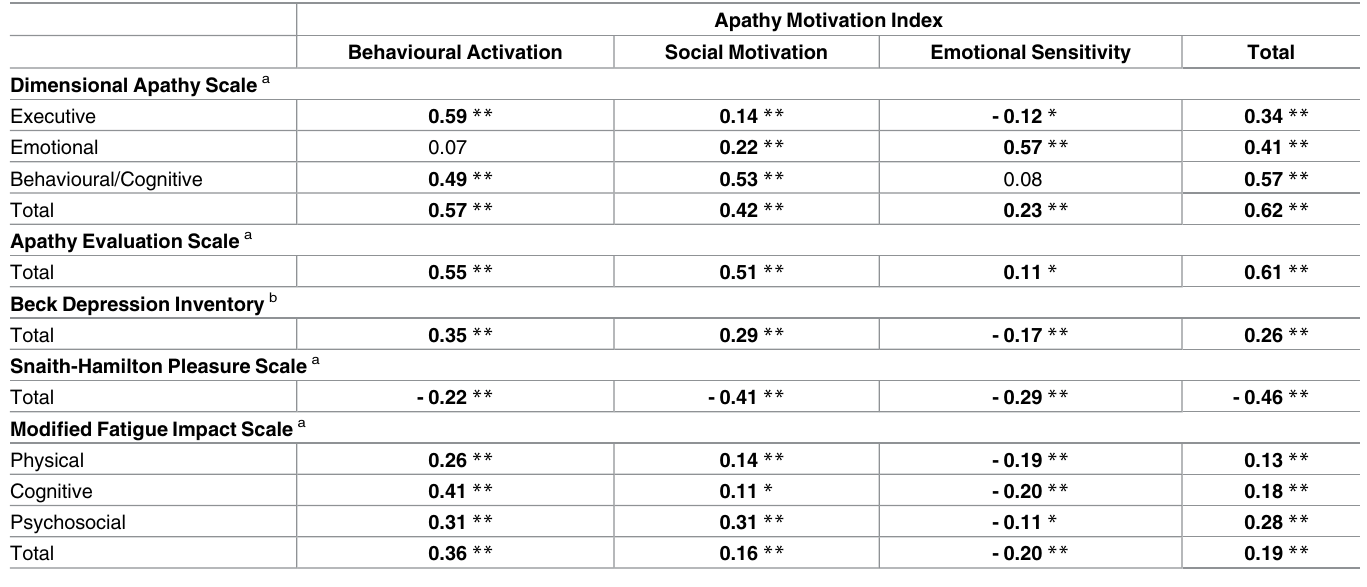
Table 5. Relationship between AMI score and established measuresof apathy (clinical indices), depression, anhedonia and